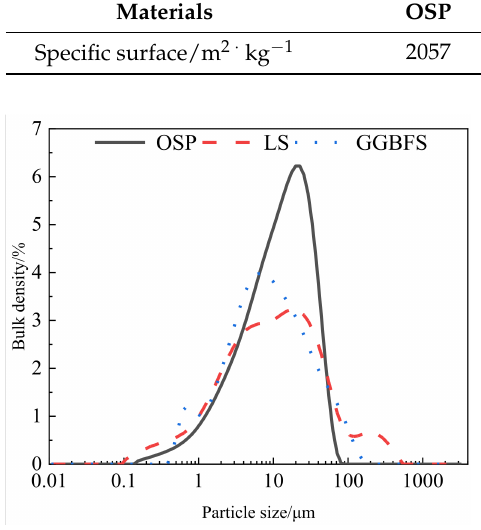
Figure 1. Particle size distribution of